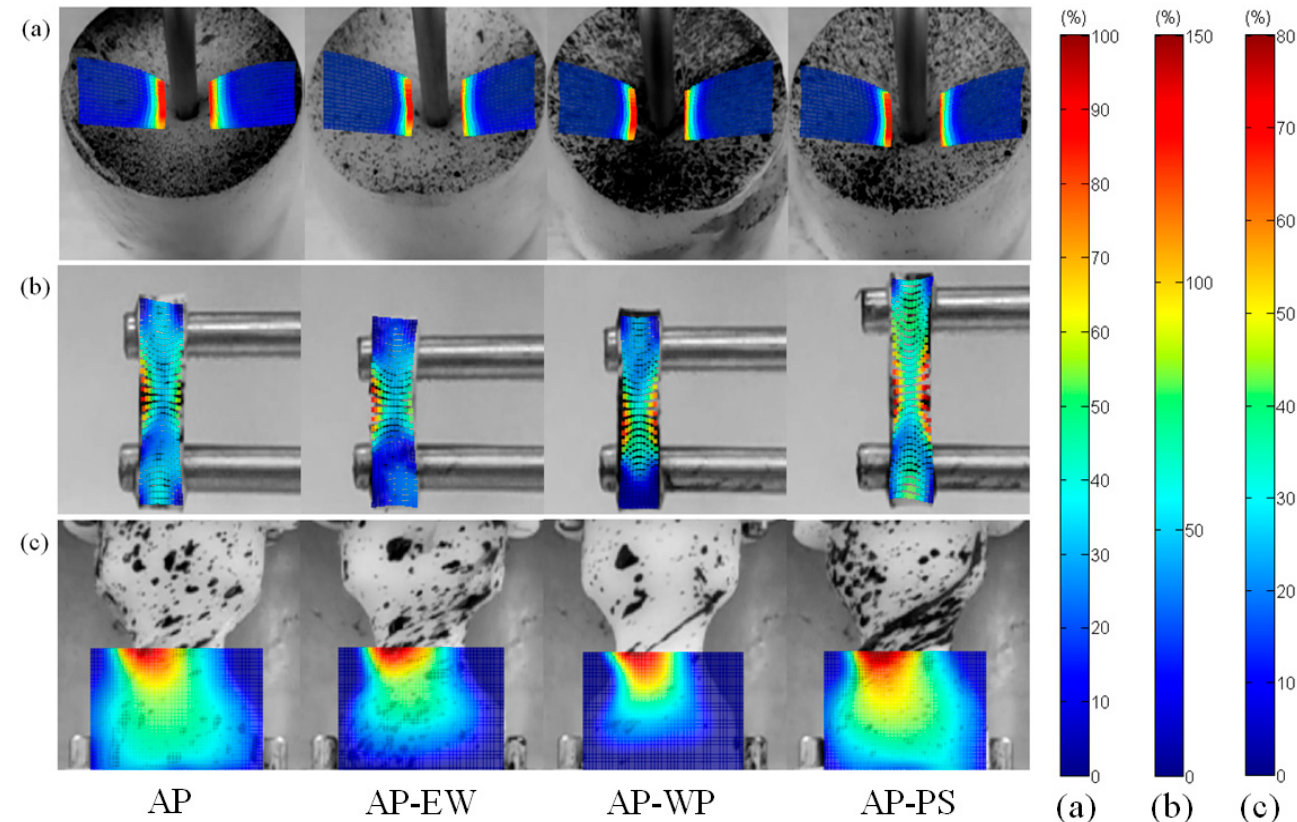
Figure 4. Representative contour plots of local strain components for the ( a ) penetration test, ( b ) failure ring tensile test, and ( c ) torsion test at failure points in each surimi gel.